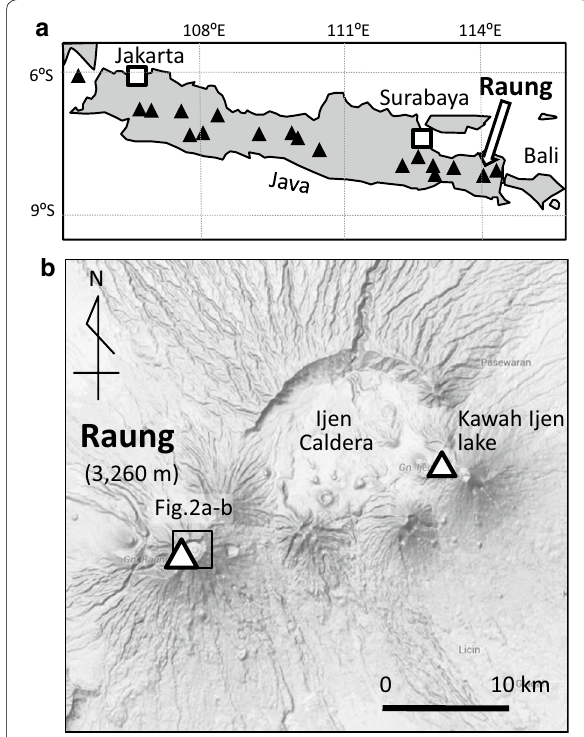
Fig. 1 a Location of Mt Raung. b Mt Raung and adjacent topography. (Reproduced from Google